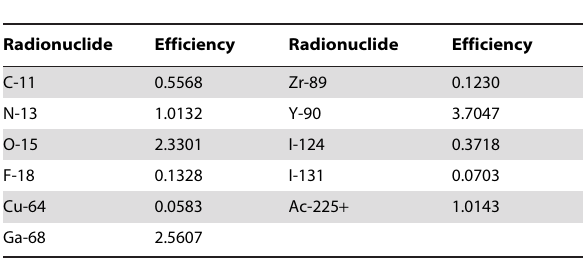
Table 4. CR from b Efficiencies.